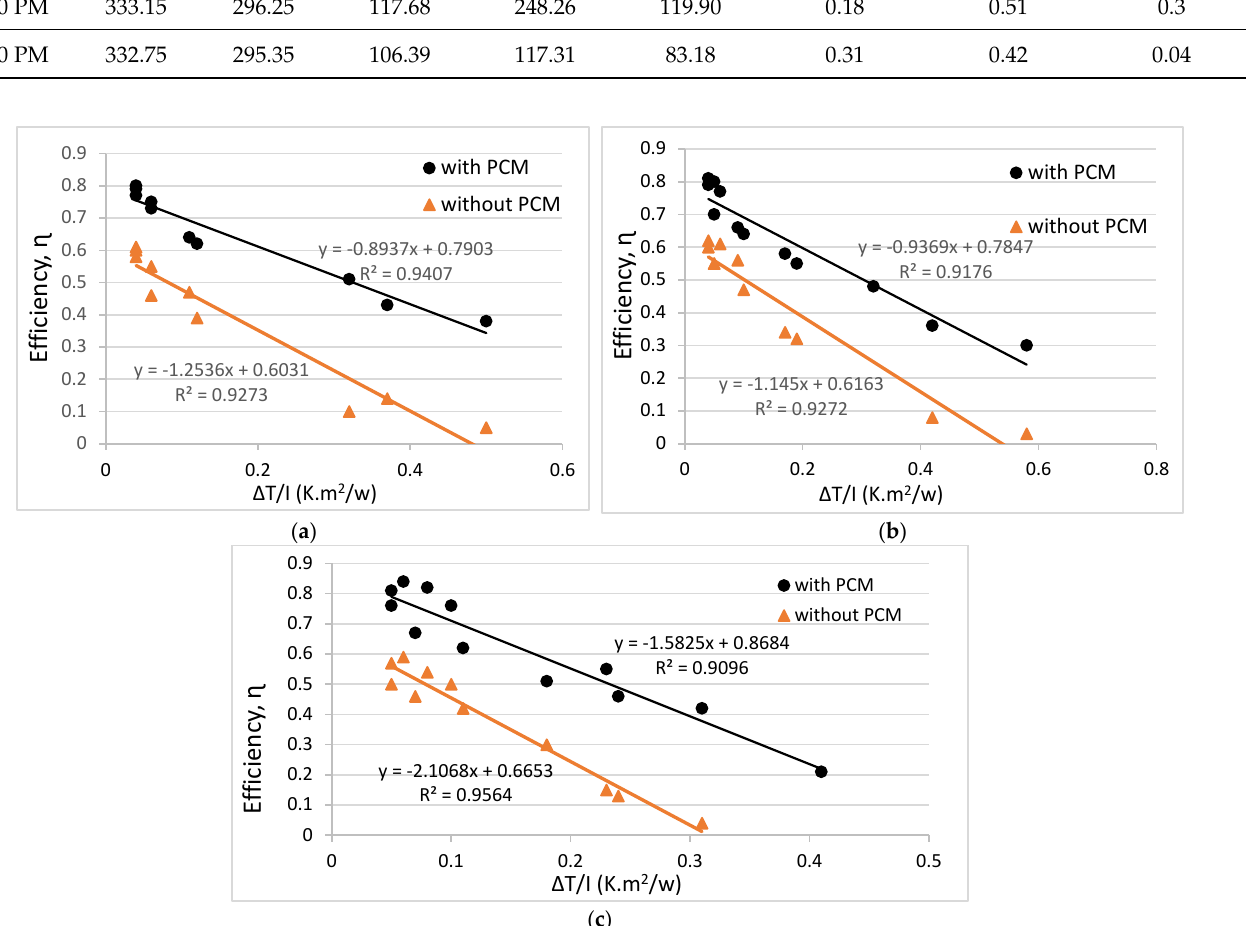
Figure 11 illustrates the relationship between the system ’ s thermal efficiency ( ɳ 𝑠𝑦𝑠𝑡𝑒𝑚 )